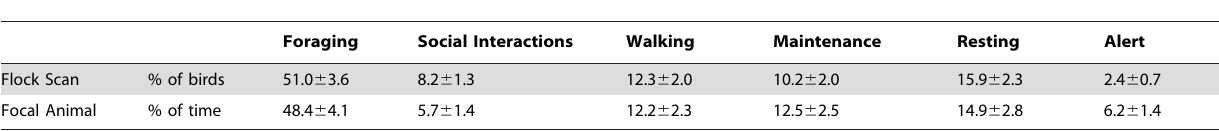
Table 1. Time budgets for Buff-breasted Sandpipers in agricultural habitats.